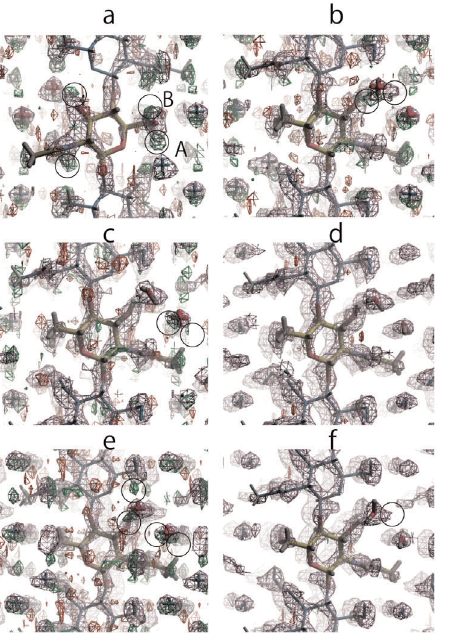
Figure 4. Neutron Fourier omit maps. Section through the neutron s A map (showing positive density in blue) and the Fo-Fc omit map (showing positive and negative density in green and red, respectively) after (a) removing all deuterium atoms (b) adding DO3, DN2 and DO6 at position A (c) further adding the deuterium atoms attached to Ow2 (d) further adding the deuterium atoms attached to Ow1 (e) adding DO3, DN2 and DO6 at position B (f) further adding the deuterium atoms attached Ow1 and Ow2. In (f) small residual peaks can still be seen near